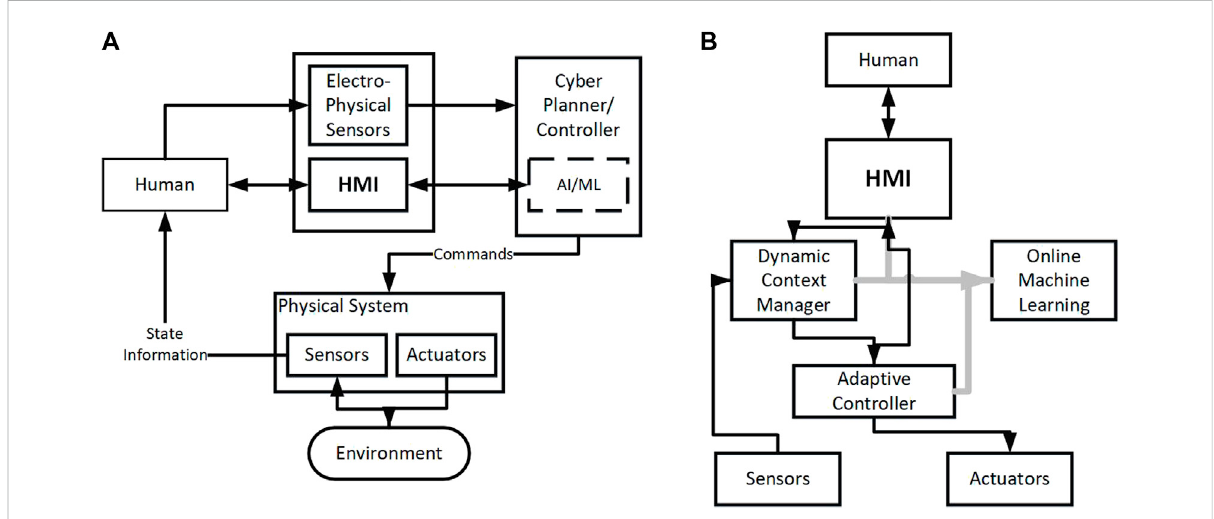
FIGURE 1 (A) AnA-HMT-SwithAIandMLembeddedinthecyberplanner/controller(AdaptedfromMadni&Madni2018). (B) AnA-HMT-Swithitscontrol elements drawing on results from separate on-line ML systems that are not in the control chain. (Adapted from Madni et al.